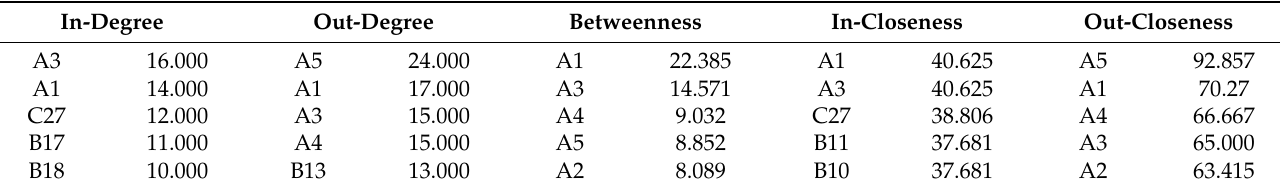
Table 2. Results of centrality.